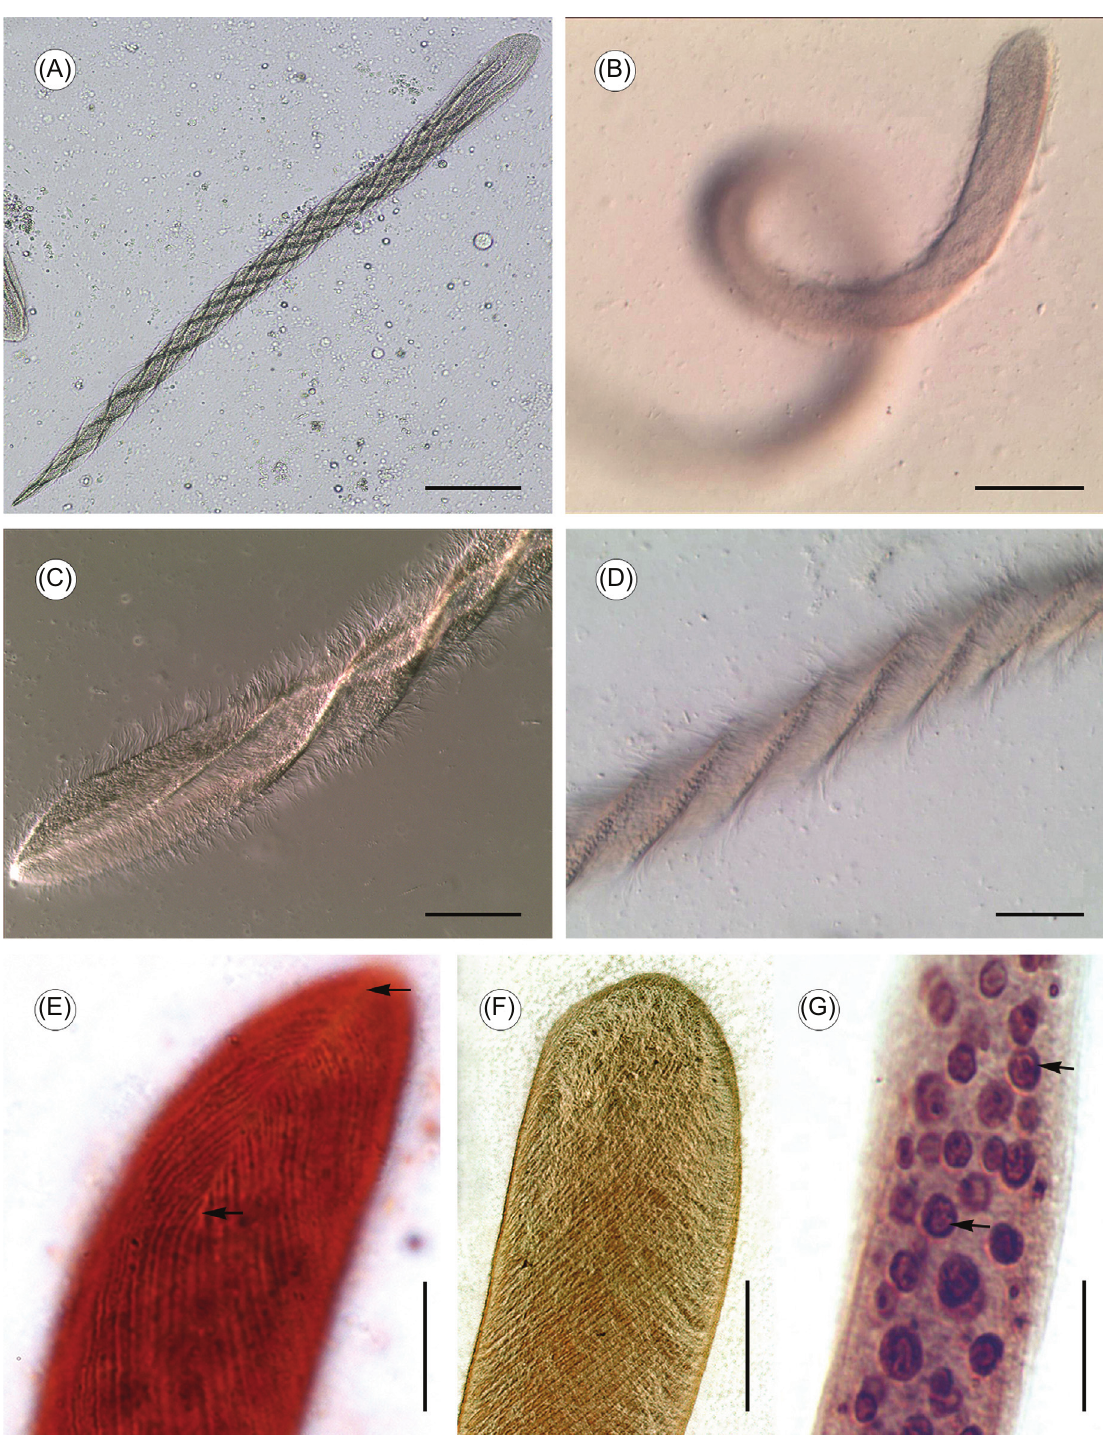
Figure 1. Light microscope images of Cepedea longa. (A) Overview of the living specimens, to show general form, greatly elongated and cylindrical, with the anterior extremity broader and the posterior end pointed. Scale bar = 100 l m. (B) Living specimens, to show C. longa thickly flagellated and often coils when swimming. Scale bar = 100 l m. (C)–(D) Living specimens, to show body surface twisting and giving a spiral appearance. Scale bar = 50 l m. (E) Specimens stained with ammoniacal silver, to show the falx (arrow) and somatic kineties branching off from each side. Scale bar = 25 l m. (F) Specimens stained with silver nitrate, to show somatic kineties follow a sigmoid course from anterior to posterior end of the cell. Scale bar = 25 l m. (G) Specimens stained with ammoniacal silver, to show the organism possessing a large amount of spherical or ellipsoidal nuclei (arrow). Scale bar = 25 l